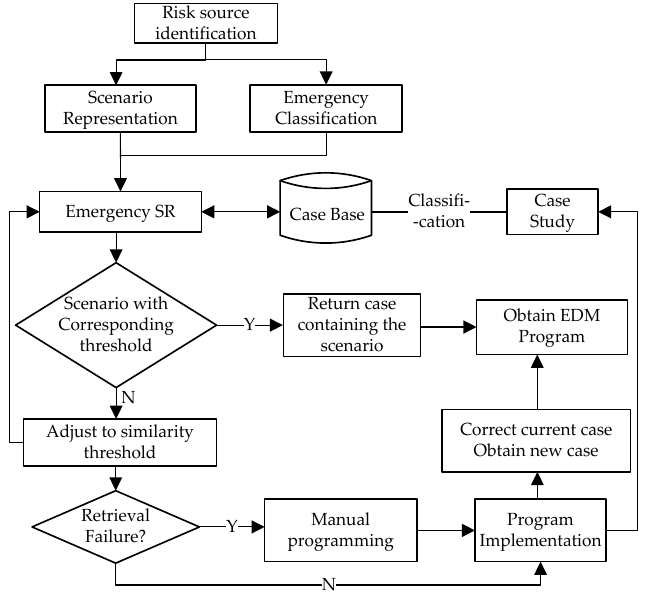
Figure 1. EDM conceptual model for WEE based on SR and CBR.